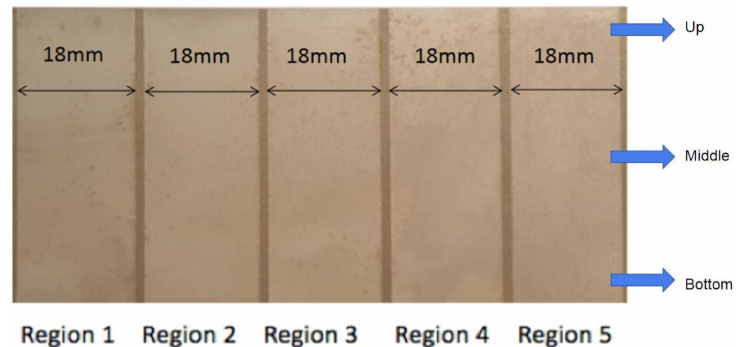
Figure 3. Surface appearance of the different regions as a function of wire infeed.